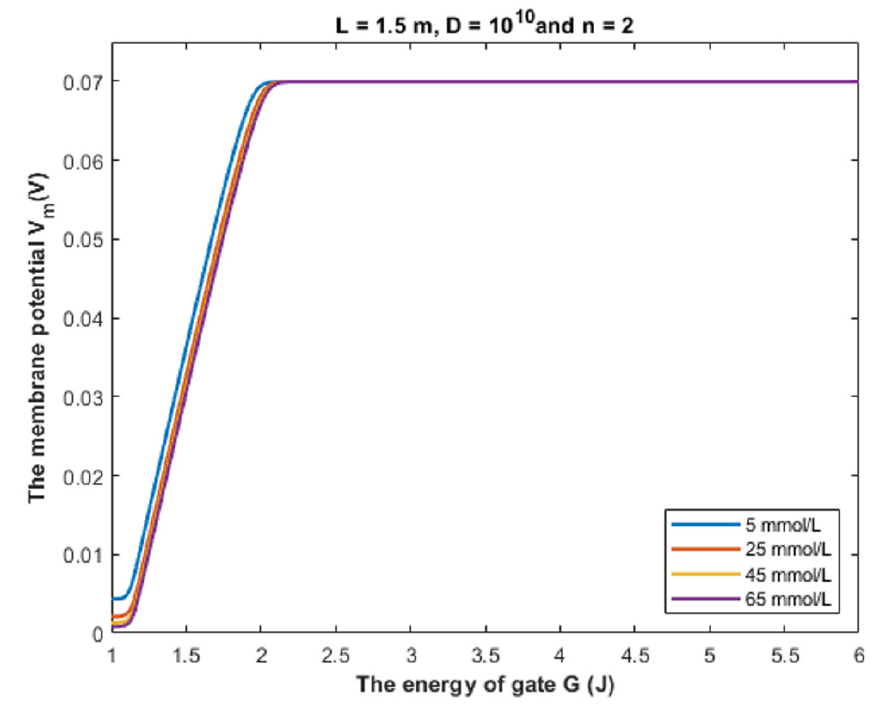
Figure 17. The figure represents the relationship between the energy of gate G and the resting membrane potential under the influence of the quantum tunneling of chloride ions at different intracellular chloride concentrations.